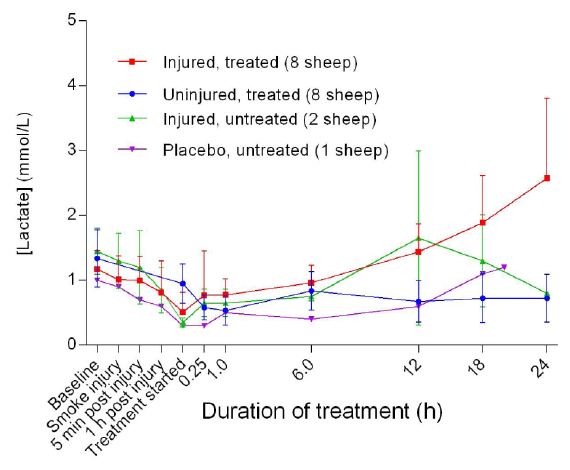
Figure 19. Blood lactate concentration (Mean ± SD) in smoke and non-smoke injured sheep that received extracorporeal life support as compared to that in untreated controls.